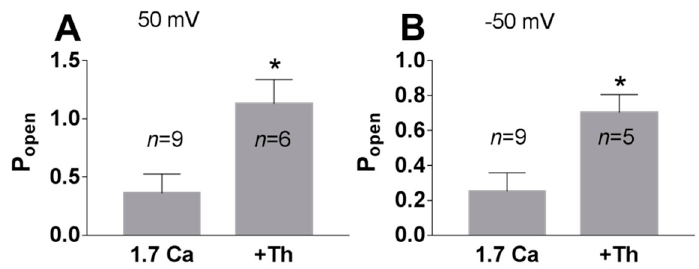
Figure 7. Effect of thapsigargin on the TREK-2 like channel activity in the cell-attached configuration. The cells were perfused with a bath solution containing 1.7 mM Ca 2+ with or without 1 µ M thap- sigargin (20–30 min pre-treatment). A significant difference in the TREK-2 like channel P open was observed: ( A ) 50 mV, * p = 0.025, Mann–Whitney test; ( B ) − 50 mV, * p = 0.023; Mann–Whitney test.